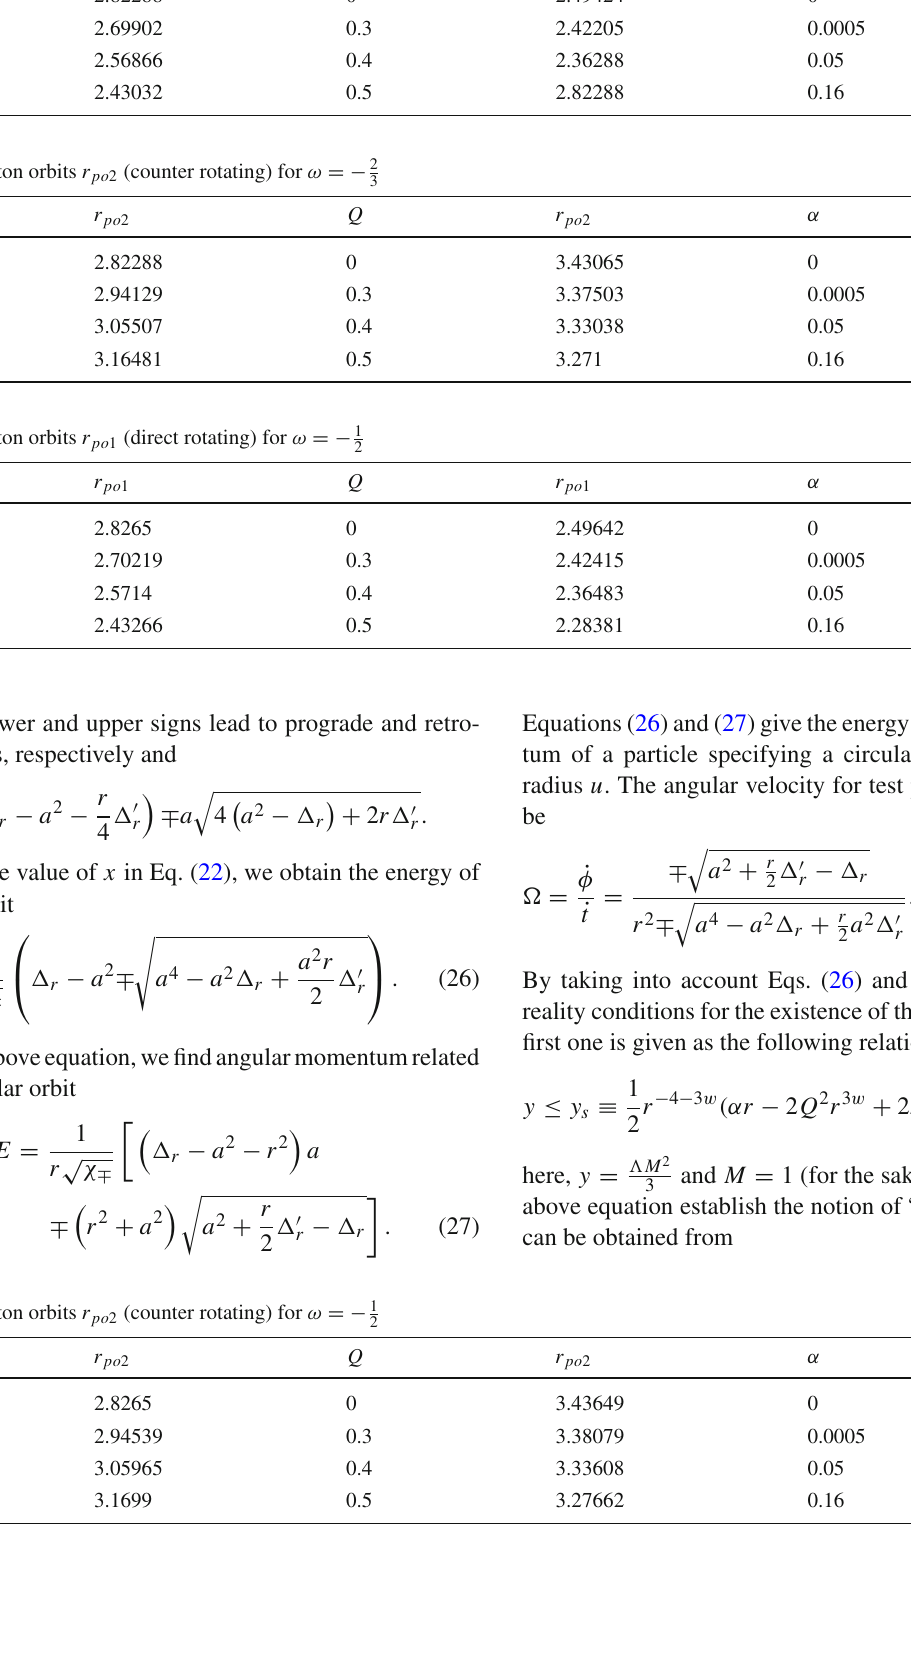
Table 1 Photon orbits r po 1 (direct rotating) for ω = − 2